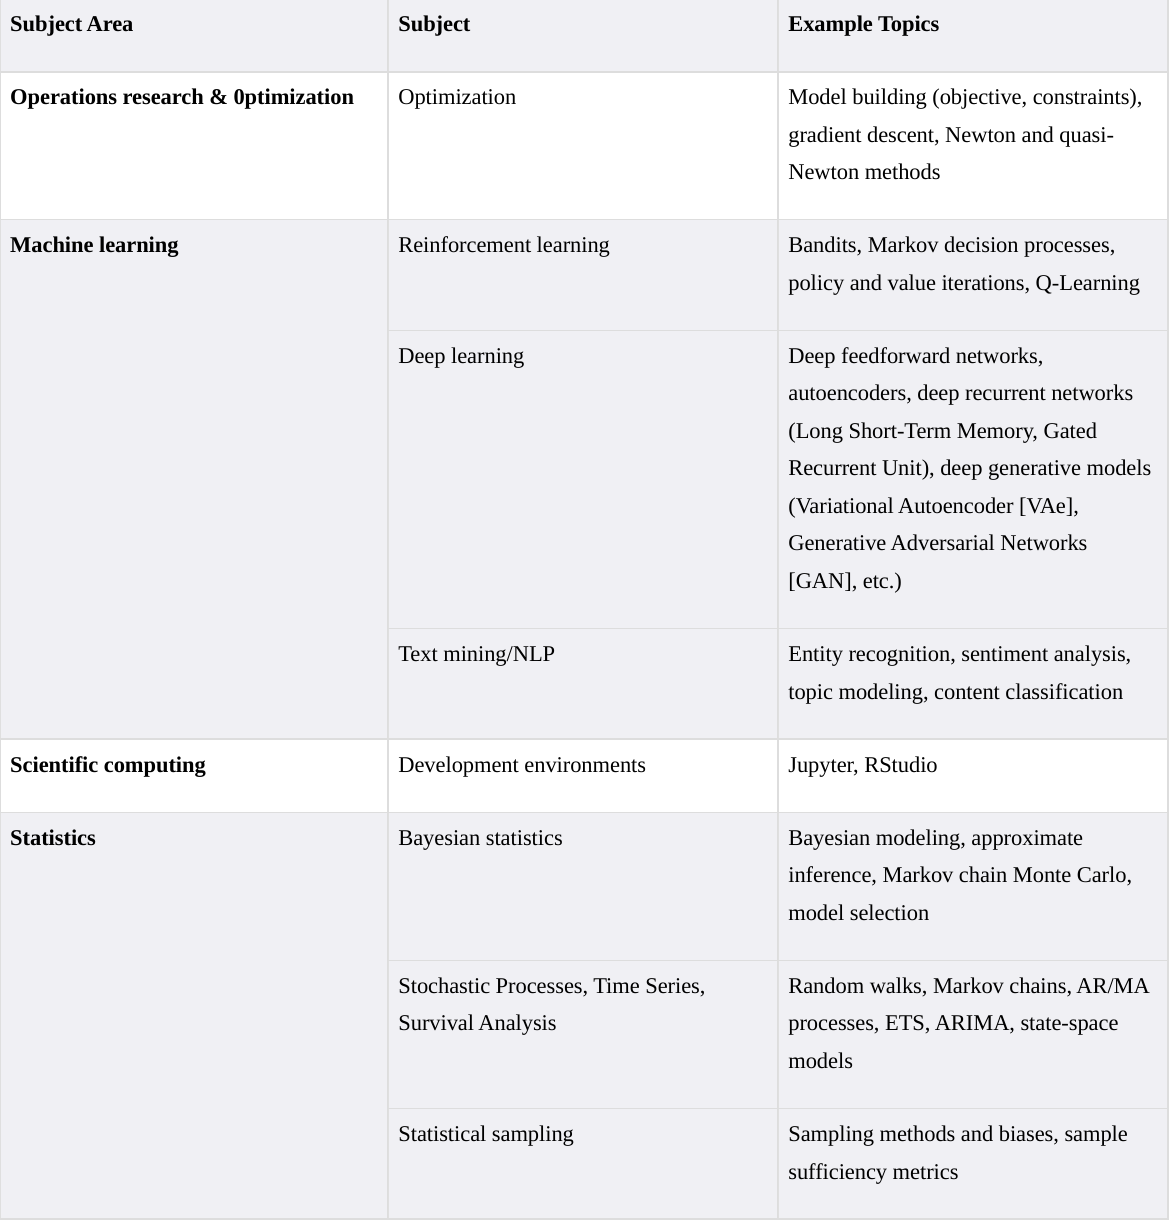
Table 9. Additional technical knowledge for the key